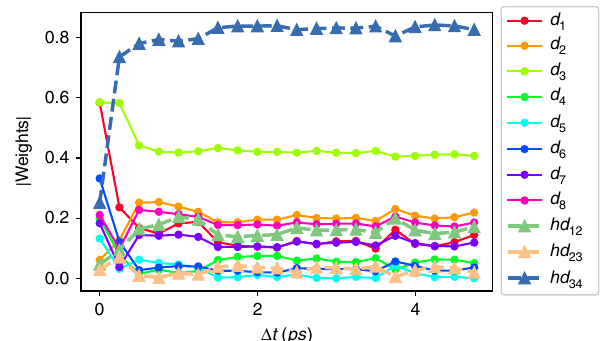
Fig. 3 Order parameters weights as functions of time delay for benzene – lysozyme dissociation. The scheme shows the absolute value of weights for 11 order parameters in the fi rst round as a function of predictive time delay